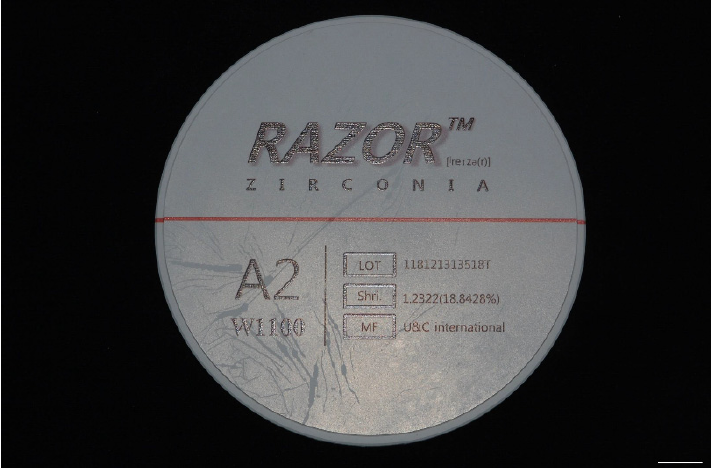
Figure 4. A disc-shaped zirconia block (Razor, U&C International Co., Ltd., Seoul, Korea). This block is partially sintered and 98 mm in diameter, and is available for a full arch implant-supported restoration. Bar = 1 cm.